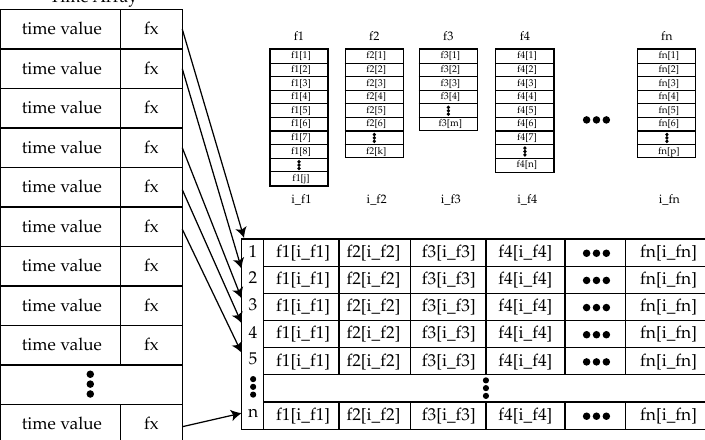
Figure 7. Diagram of the dataset generation process.